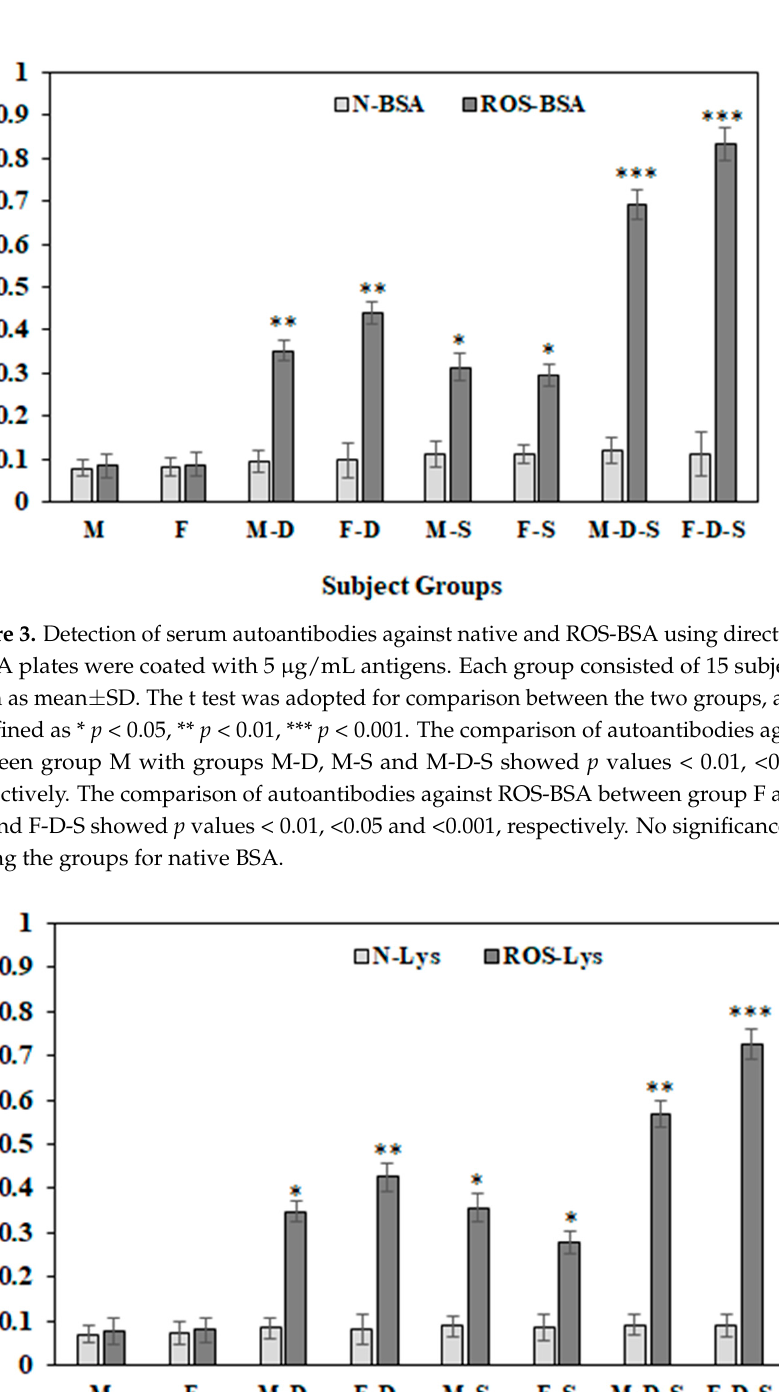
Figure 4. Detection of serum autoantibodies against native and ROS-Lys using direct binding ELISA. ELISA plates were coated with 5 µ g/mL antigens. Each group consisted of 15 subjects. Values are given as mean ± SD. The t test was adopted for the comparison between the two groups, and significance is defined as * p < 0.05, ** p < 0.01, *** p < 0.001. The comparison of autoantibodies against ROS-Lys between group M with groups M-D, M-S and M-D-S showed p values < 0.05, <0.05 and <0.01, respectively. The comparison of autoantibodies against ROS-Lys between group F and groups F-D, F-S and F-D-S showed p values < 0.01, <0.05 and <0.001, respectively. No significance was observed amongst the groups for native